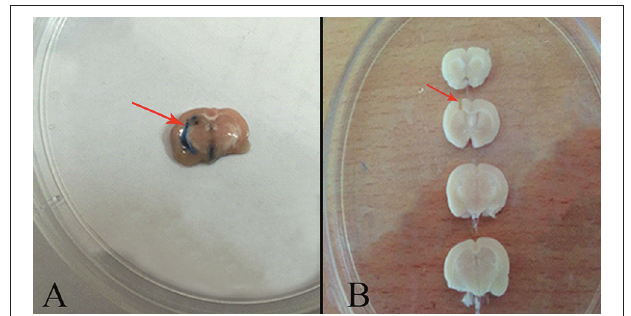
FIGURE 2 | (A) Area of trypan blue injection into the left lateral cerebroventricle (arrow). (B) The area of cannula implantation into the left lateral cerebroventricle